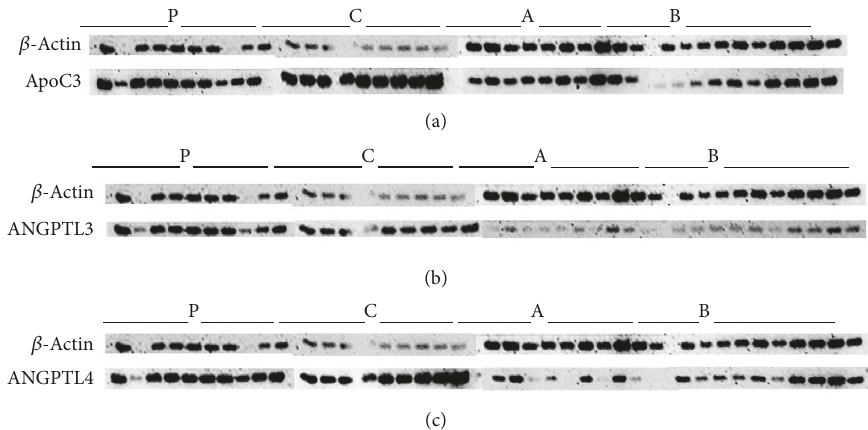
Figure 3: (a) ApoA5 is significantly upregulated in the linoleic acid control group (C group). P group (Standard Chow), C group (chow supplemented with linoleic acid 9 mg/mouse/day), A group (chow supplemented with oxidized linoleic acid 9mg/mouse/day), and B group (chow supplemented with linoleic acid 18 mg/mouse/day). (b) ApoC3 is nonsignificantly upregulated in the linoleic acid control group (C group). P group (Standard Chow), C group, A group (chow supplemented with oxidized linoleic acid 9mg/mouse/day), and B group (chow supplemented with linoleic acid 18 mg/mouse/day). (c) SREBP gene expression shows significant upregulation in the mice group fed a high concentration of oxidized linoleic acid. P group (Standard Chow), C group (chow supplemented with linoleic acid 9mg/mouse/day), A group (chow supplemented with oxidized linoleic acid 9mg/mouse/day), and B group (chow supplemented with linoleic acid 18 mg/mouse/day). (d) Slight peak in the PPAR- 𝛼 gene expression in the linoleic acid control group (C group) and decreased expression in both oxidized linoleic acid concentration groups (A and B groups): P group (Standard Chow), C group (chow supplemented with linoleic acid 9 mg/mouse/day), A group (chow supplemented with oxidized linoleic acid 9 mg/mouse/day), and B group (chow supplemented with linoleic acid 18mg/mouse/day).